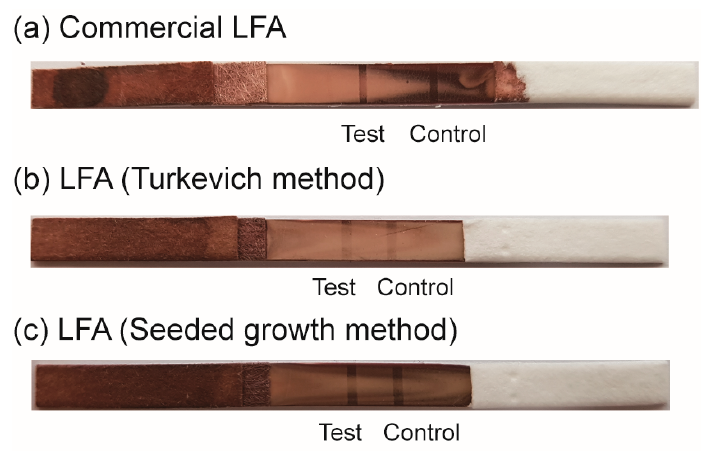
Figure 7. Photograph images of the practical test of LFAs (( a ) commercialized HBV diagnosis kit (Humasis); ( b ) LFA based on Turkevich-Frens method; and ( c ) our LFA developed in this work) using human whole blood samples.